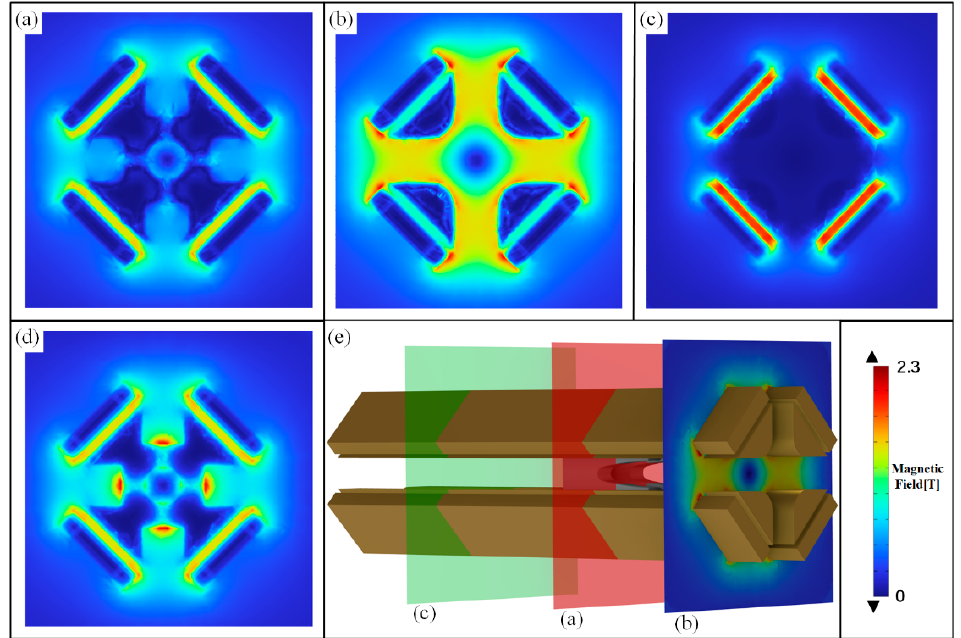
Figure 14. Magnetic field distribution in the bore of the augmented quadrupole railgun. ( a ) Magnetic field in x and y directions on section a; ( b ) Magnetic field in x and y directions on section b. ( c ) Magnetic field in x and y directions on section c; ( d ) Total magnetic field norm on section a. ( e ) Schematic diagram of the rail gun and section location.